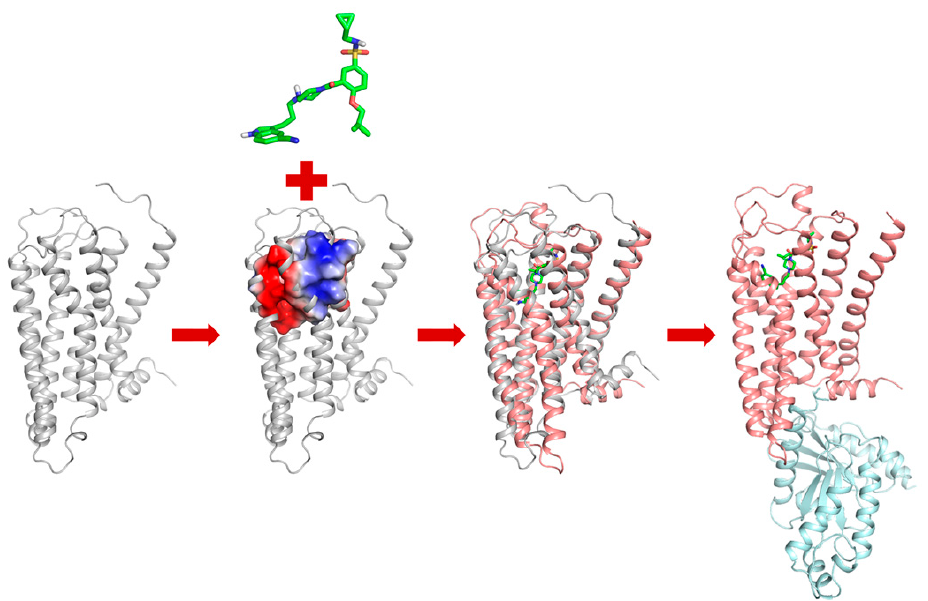
Figure 6. Proposed activation process of 5-HT 1A R. The apo system and surrounding residues are represented as grey. The 13m -5-HT 1A R system and surrounding residues are represented as pink. The G α / s protein is represented as blue.